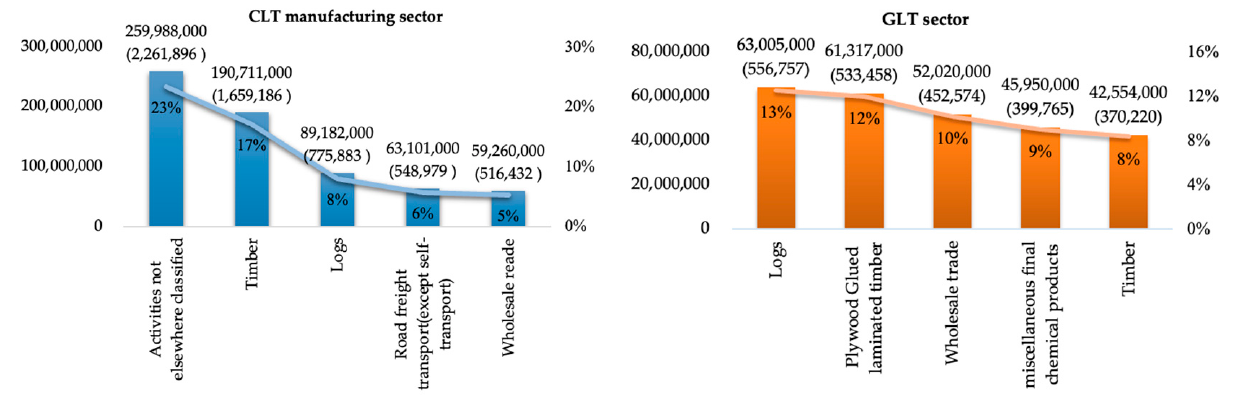
Figure 5. The top five sectors impacted by the indirect effects (unit: JPY (USD); “%” indicates the percentage of the sector relative to the indirect effect).